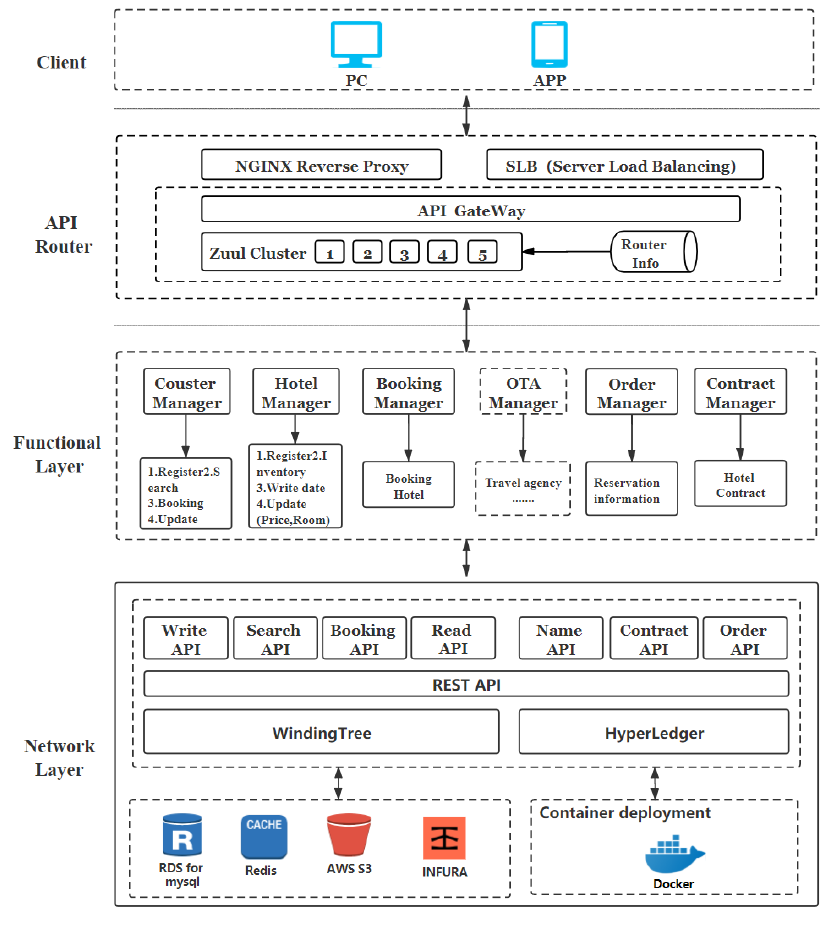
Figure 11. Configuration diagram of the prototype for the tourism service.